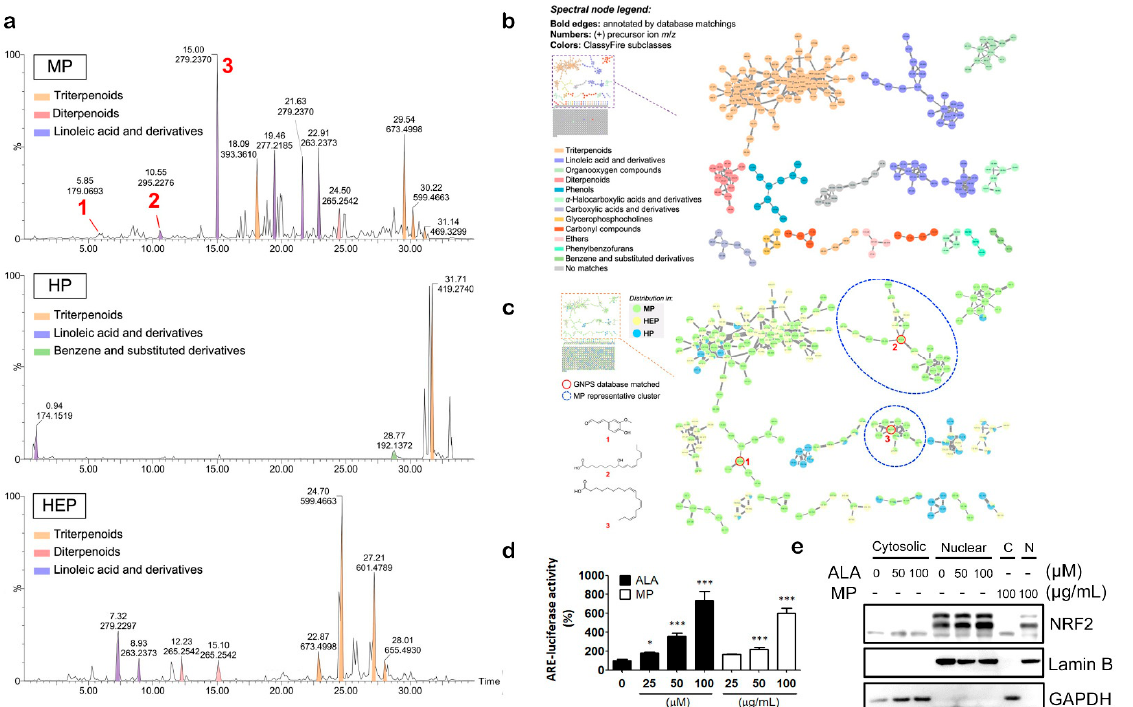
Figure 5. The chemical profiles and molecular evidence indicated that ALA could be an active component in Prinsepiae Nux. ( a ) The UPLC-MS total ion chromatogram was performed in positive mode. ( b , c ) The automated chemical classification was analyzed using ClassyFire from the GNPS platform. The annotations of constituents were carried out automatically through GNPS library matches. ( b ) The classical molecular network spectral nodes are colored according to ClassyFire classes; ( c ) the representative distributions of constituents in the Prinsepiae Nux extracts. ( d ) HaCaT/ARE cells were treated with indicated concentrations of ALA or MP fraction for 18 h for reporter assay. DMSO solvent control was used as 100%. Data are presented as mean ± SD from three independent experiments. ( e ) HaCaT cells were incubated with ALA or MP fraction for 4 h and harvested for immunoblot. Data are presented as mean ± SD from three independent experiments. The asterisk (*) indicates a significant difference from the solvent control cells. (* p < 0.05, *** p < 0.001, one-way ANOVA).